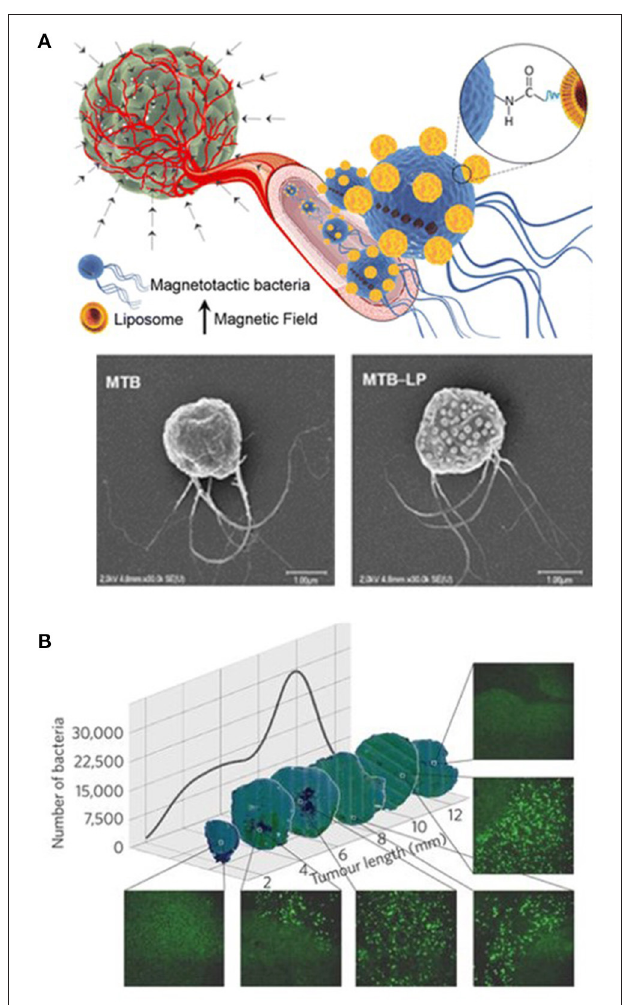
FIGURE 2 | Nanorobots for delivery usage. (A) Schematic illustration and SEM of biohybrid nanorobot including a magnetotactic bacteria loaded with liposomes. Reprinted with permission from Taherkhani et al. (2014). Copyright 2014 American Chemical Society. (B) Fluorescent images of transverse tumor sections illustrating the biohybrid robot distribution and population inside the tumor. Reprinted with permission from Felfoul et al. (2016). Copyright 2016 Springer